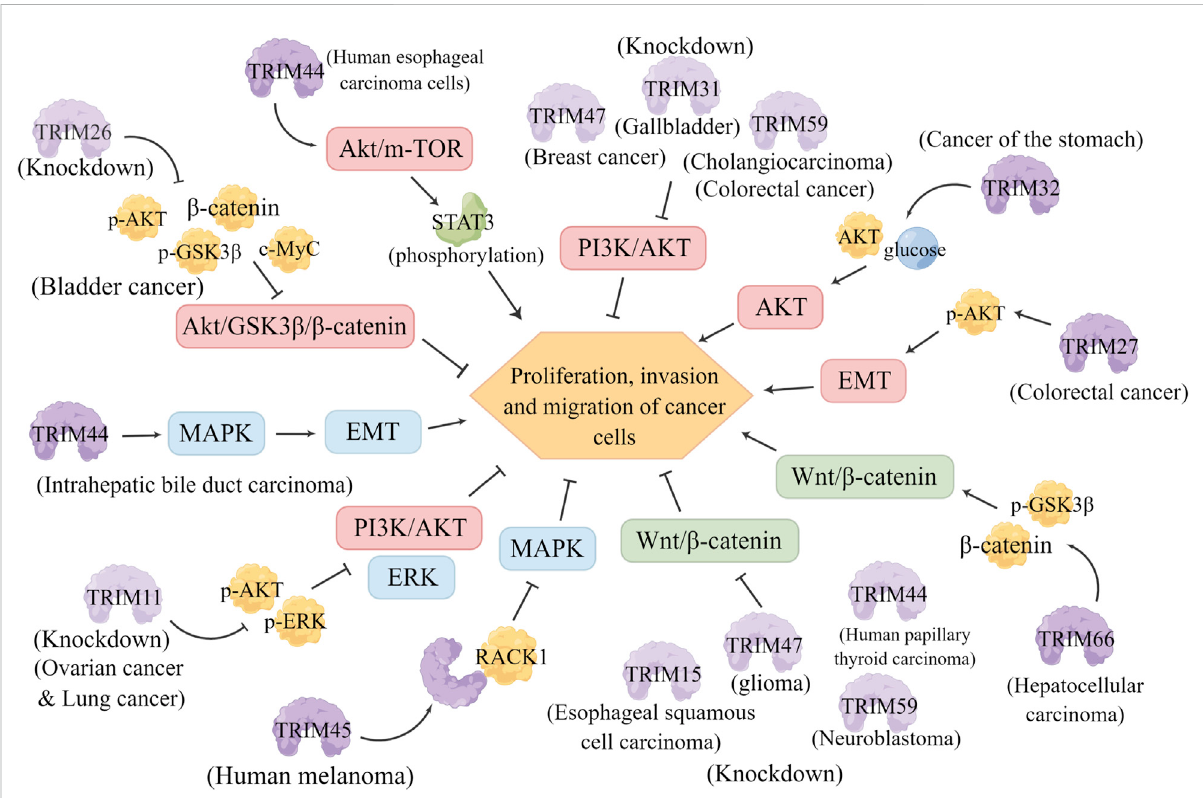
FIGURE 5 TRIMs in other signaling pathways. Relationship between TRIM family members and the AKT, MAPK, Wnt/ β -catenin signaling pathways in different tumors and their regulatory mechanisms. Knockdown of TRIM proteins is indicated by a lightened color of the same pattern. AKT signaling pathway (red): Knockdown of TRIM26 signi fi cantly reduced the levels of p-Akt, p-GSK3 β , β -catenin and c-Myc in bladder cancer cells, and inhibited the proliferation, invasion and migration of bladder cancer cells by inhibiting the Akt/GSK3 β / β -catenin pathway. TRIM44 is involved in the phosphorylation of the AKT/mTOR signaling pathway and its downstream target gene STAT3, which signi fi cantly promotes the proliferation, migration and invasionof human esophagealcancer cells. Knockdown ofTRIM47, TRIM31and TRIM59 inhibited tumorigenesis anddevelopment by inhibiting the PI3K/AKT pathway. TRIM32 promotes cell growth by enhancing AKT activity and glucose transport. TRIM27 promotes EMT and activates p-Akt to promote cell proliferation, invasion and